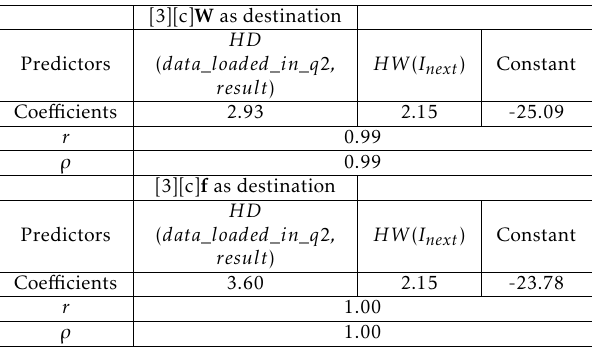
Table 2. Regression analysis of power consumption in Q2 Table 3. Regression analysis of power consumption in